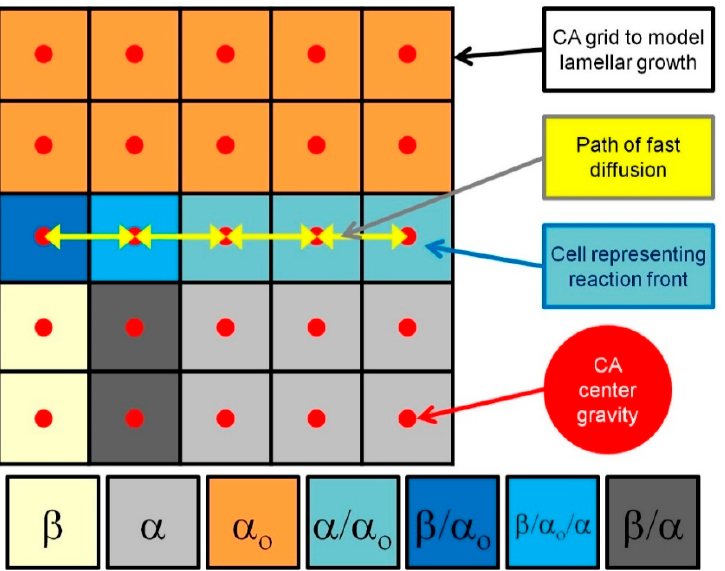
Figure 1. Grid scheme presenting CA grid to model lamellar growth and solute fast diffusion.